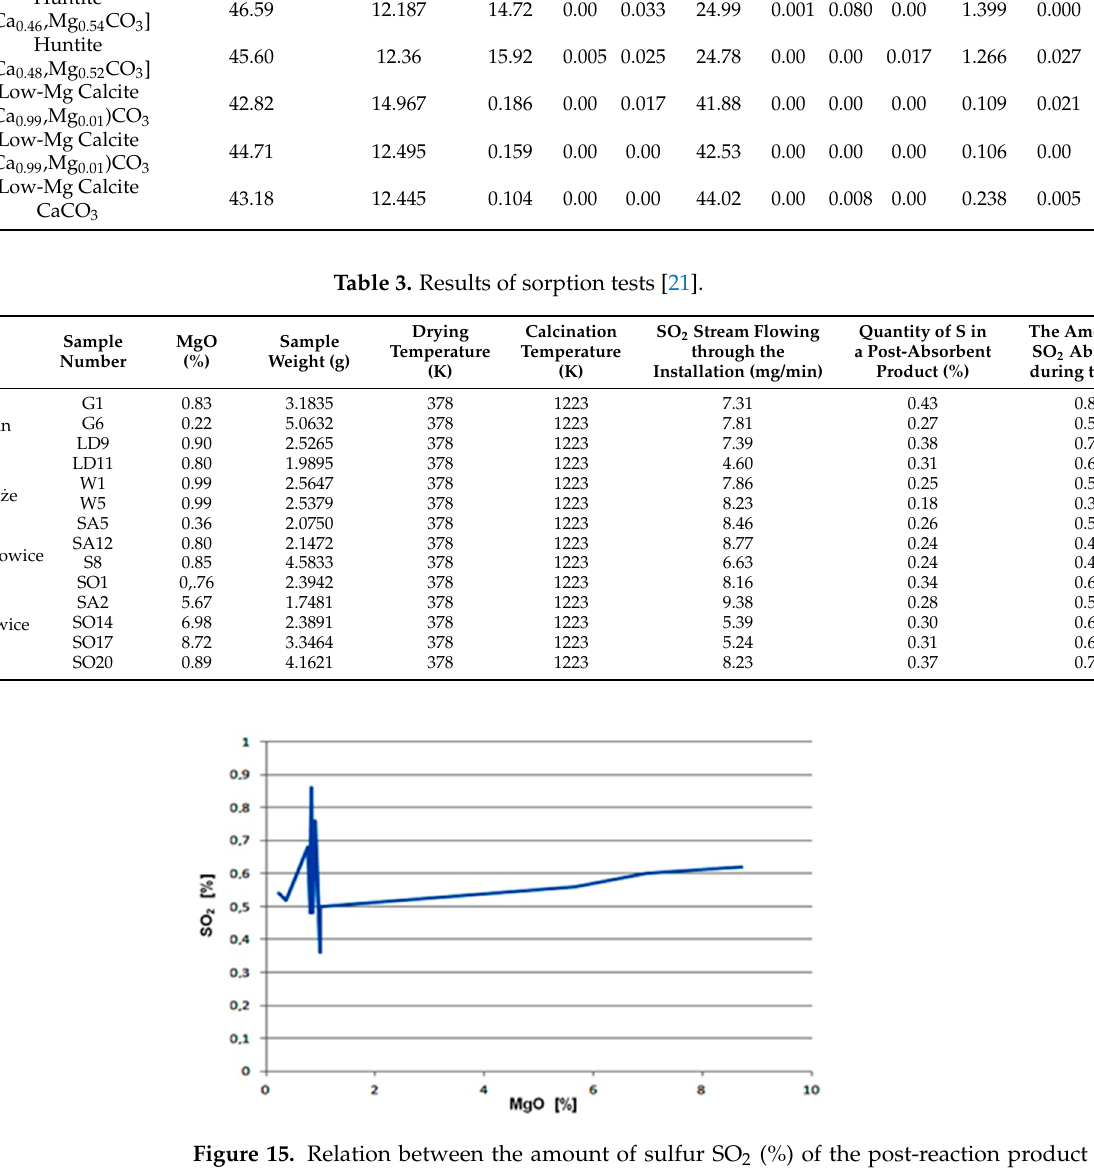
Figure 16. The amount of absorbed SO 2 (%) of the post-reaction product by carbonate sorbent sam- ples with varied content of the MgO (%) [21]. Red line- the trend line of the probable increase. The slight variation in the value of sulfur dioxide absorbed by the calcareous sorbent samples may also be the result of a variable SO 2 stream flow through the installation (Ta- ble 3) and may also be related to the nature of the specific surface of the sorbent sample subjected to the sorption process [21,48,49]. Similar dependencies were shown by the cal- culated sulfur contents determined in the post-reaction product (Figures 17 and 18). This confirms the thesis that it is possible to observe the influence of the MgO content on the amount of absorbed SO 2 and the efficiency of the flue gas desulfurization using a sorbent in which the amount of MgO will exceed the value of 1% [21,48,49]. Figure 17. Relation between the amount of sulfur S (%) of the post-reaction product and the MgO (%) content of carbonate sorbent [21].